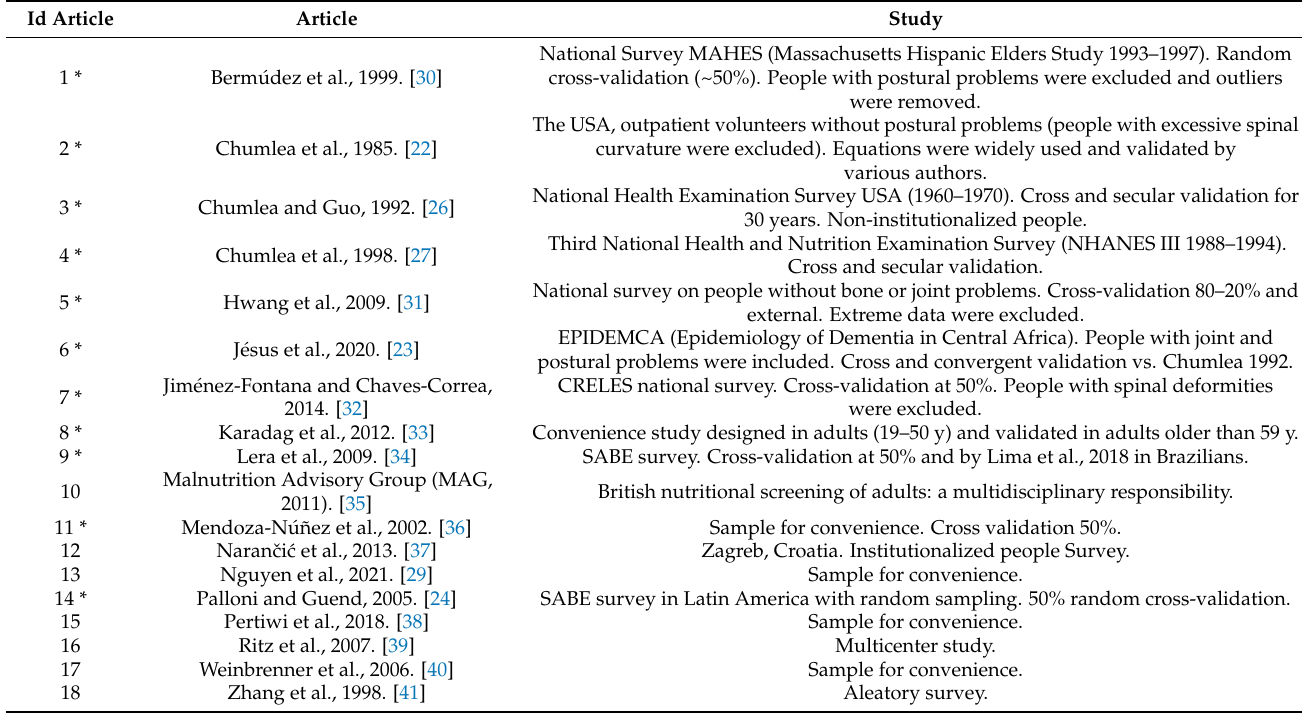
Table 3. Articles and studies where the analyzed anthropometric equations (eqs) are